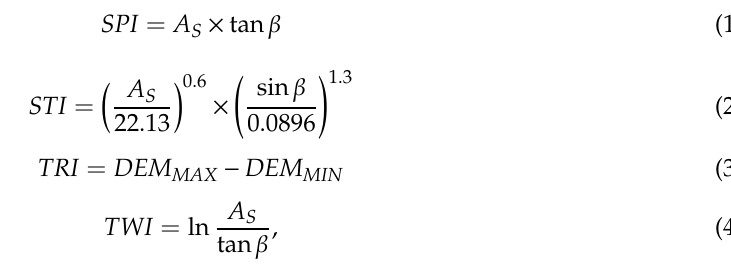
training set and test set. The third step is LSM generation: using the RF model, GBDT model and Bayesian optimized RF (RF_B) and GBDT (GBDT_B) models to train the training set samples and di ff erence among the four models using various evaluation methods to